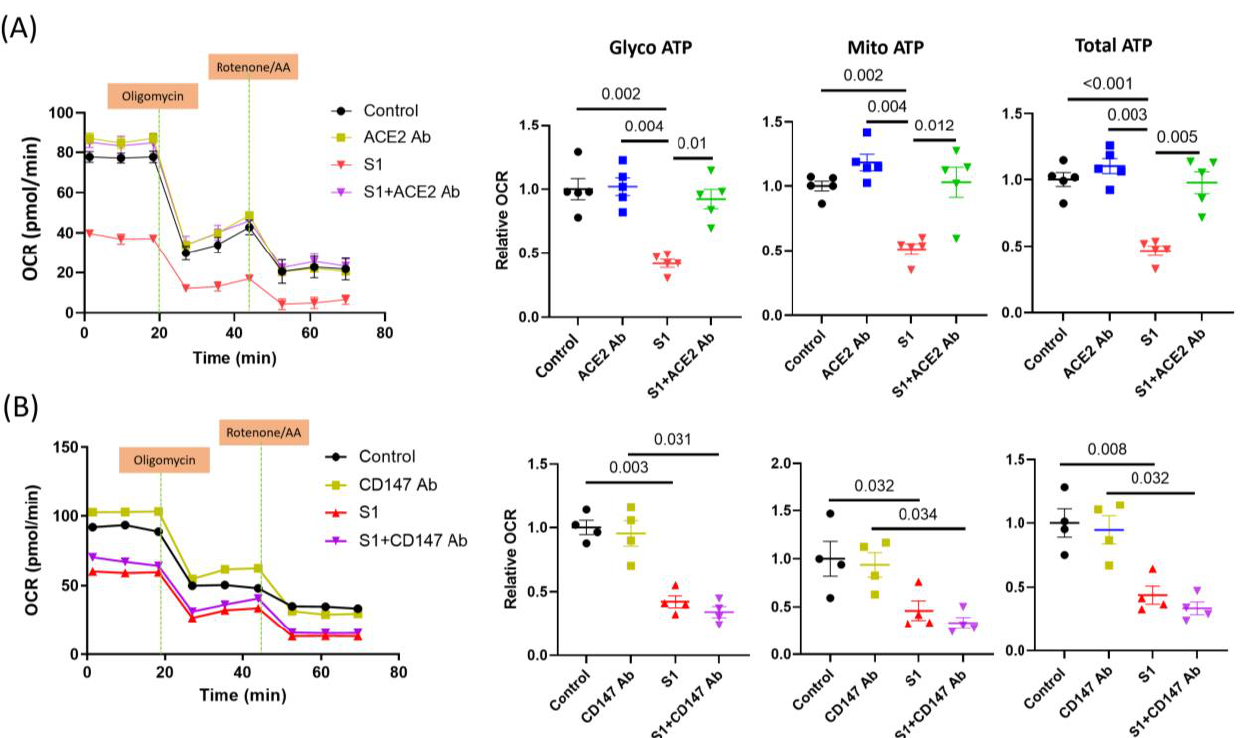
Figure 6. Effects of S1 protein on AC16 mitochondrial ATP respiration in presence of anti-CD147 and anti-ACE2 neutralizing antibodies. Anti-ACE2 antibody ( n = 5 independent experiments), but not anti-CD147 ( n = 4 independent experiments), blocked the effects of S1 (72 h) on mitochondrial ATP production in AC16 cells. One-way ANOVA followed by Tukey post-hoc analysis was used for comparing the difference between groups.